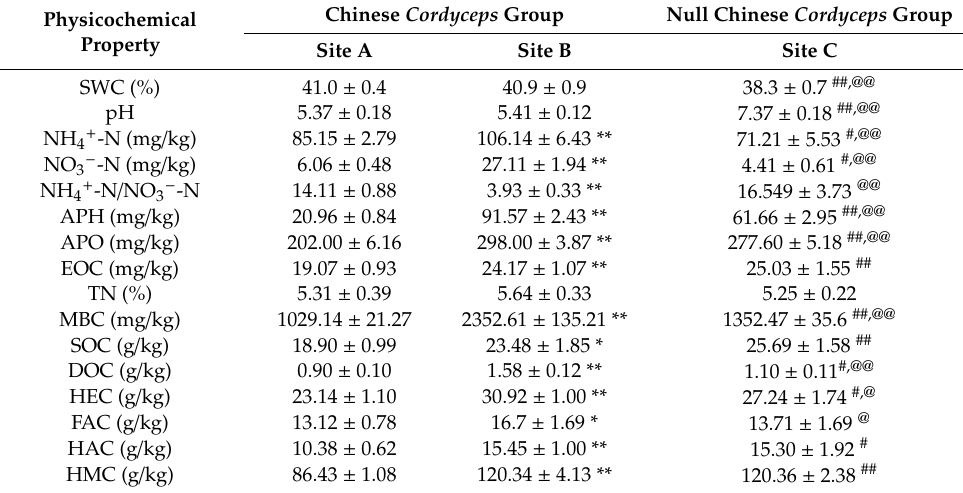
Table 2. Physicochemical properties of soil samples at each site.